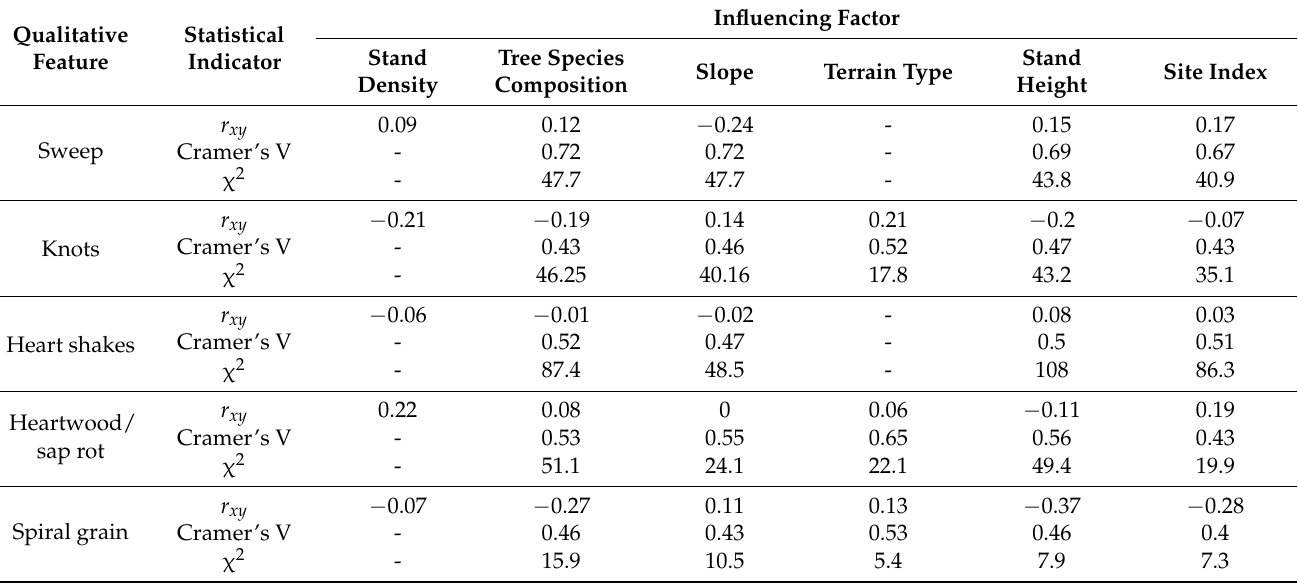
Table 3. Statistical dependence of the size of individual qualitative features of oak trunks on selected factors in individual forest